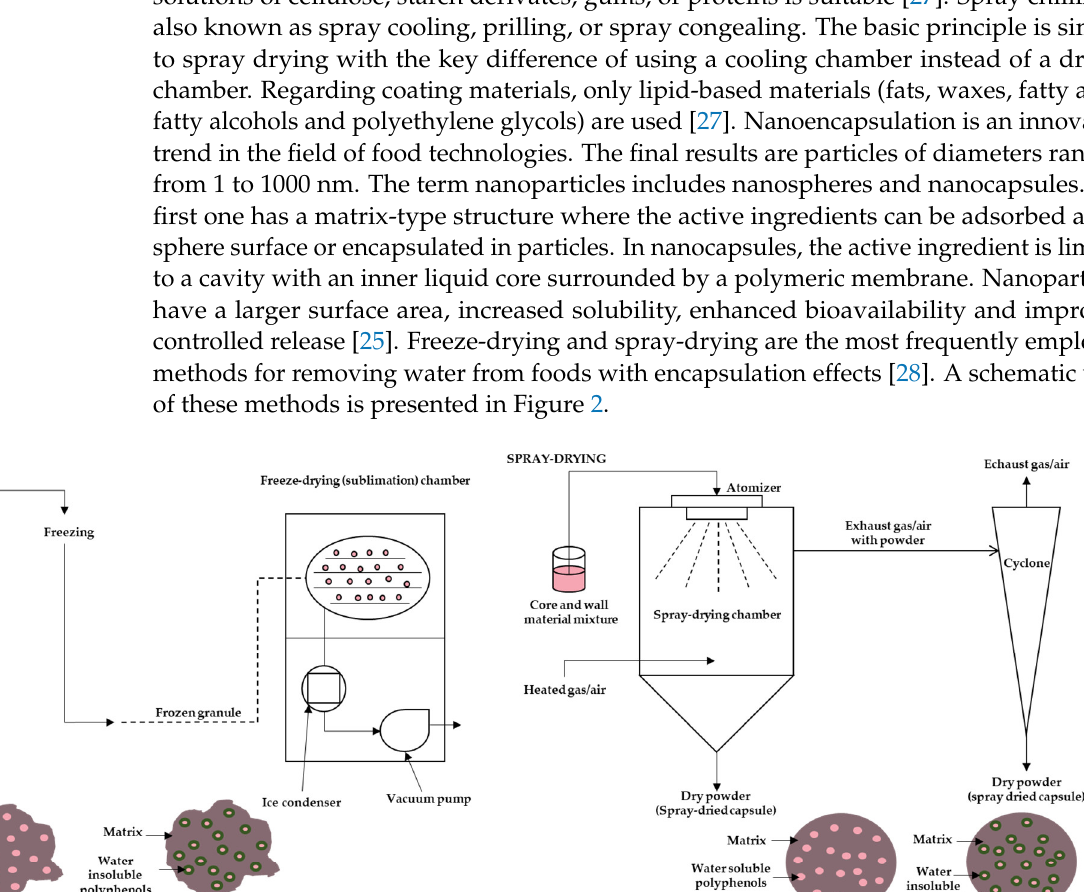
4 of 21 wall material is sodium alginate while calcium chloride solution serves for capsule form- ing. It is easy to execute on a laboratory scale with long shelf-life capsules, while scale-up of this technique is expensive and demanding with a limited choice of wall materials [26]. Emulsification includes the dispersion of one liquid into the other (two immiscible liquids) in the form of droplets. An emulsifier is required for stabilization and by application of drying, a powder form of encapsulates can be achieved [26]. The molecular inclusion